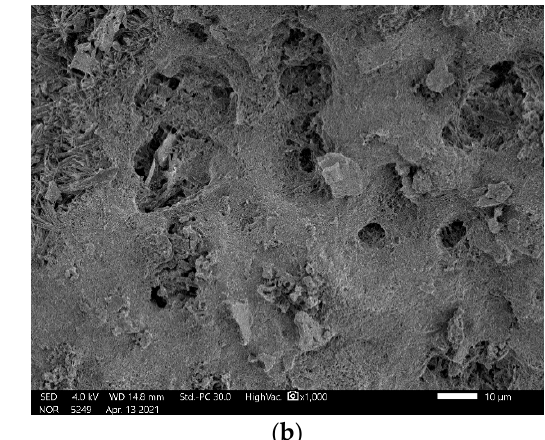
Figure 15. After corrosion with hydrochloric acid. ( a ) D0 after corrosion with hydrochloric acid; ( b ) P2 after corrosion with hydrochloric acid.